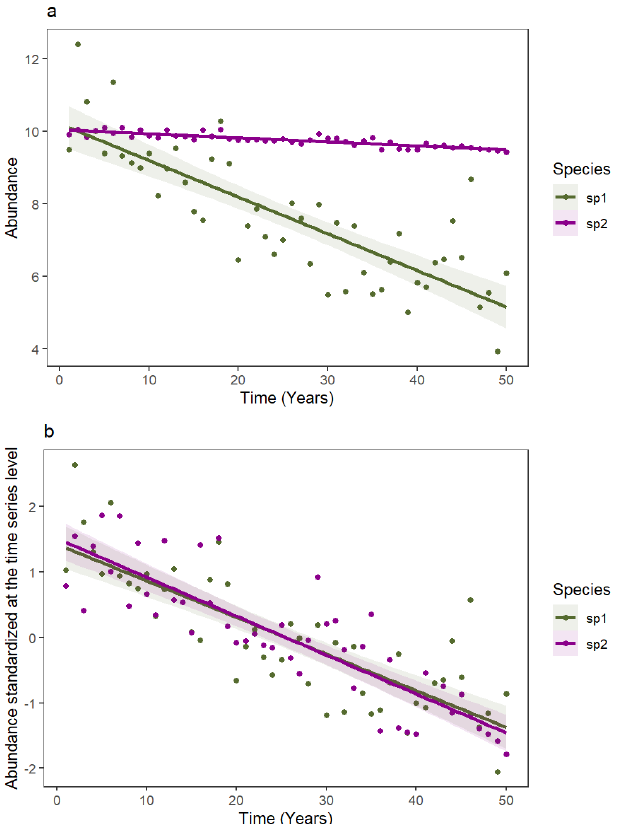
Figure S4: Simulated data showing how standardization can affect abundance trends. (a) abundance values over time and associated abundance trends, for one strongly declining species, with high inter- annual variation in abundance (green), and for another species slightly declining, with low inter-annual variation in abundance (purple). (b) shows the same data as in (a) but after standardization of abundance values within each time series (minus mean and then divided by standard deviation). In (b) abundance trends are calculated on standardized data, giving similar trends among species while in fact the green species is declining more than the purple one. Because purple species exhibit low inter-annual variability in abundance, the absolute value of its trend is artefactually increased by the